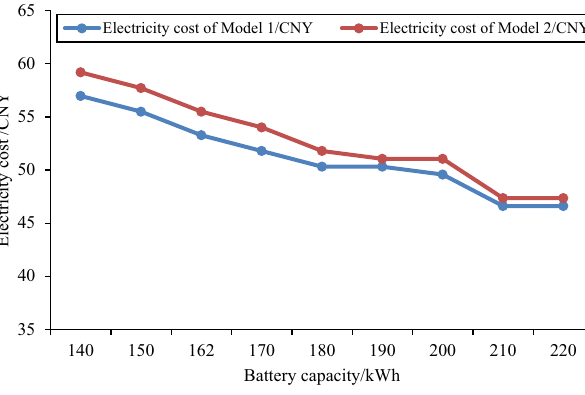
Figure 2 The minimum electricity cost with different battery capacities